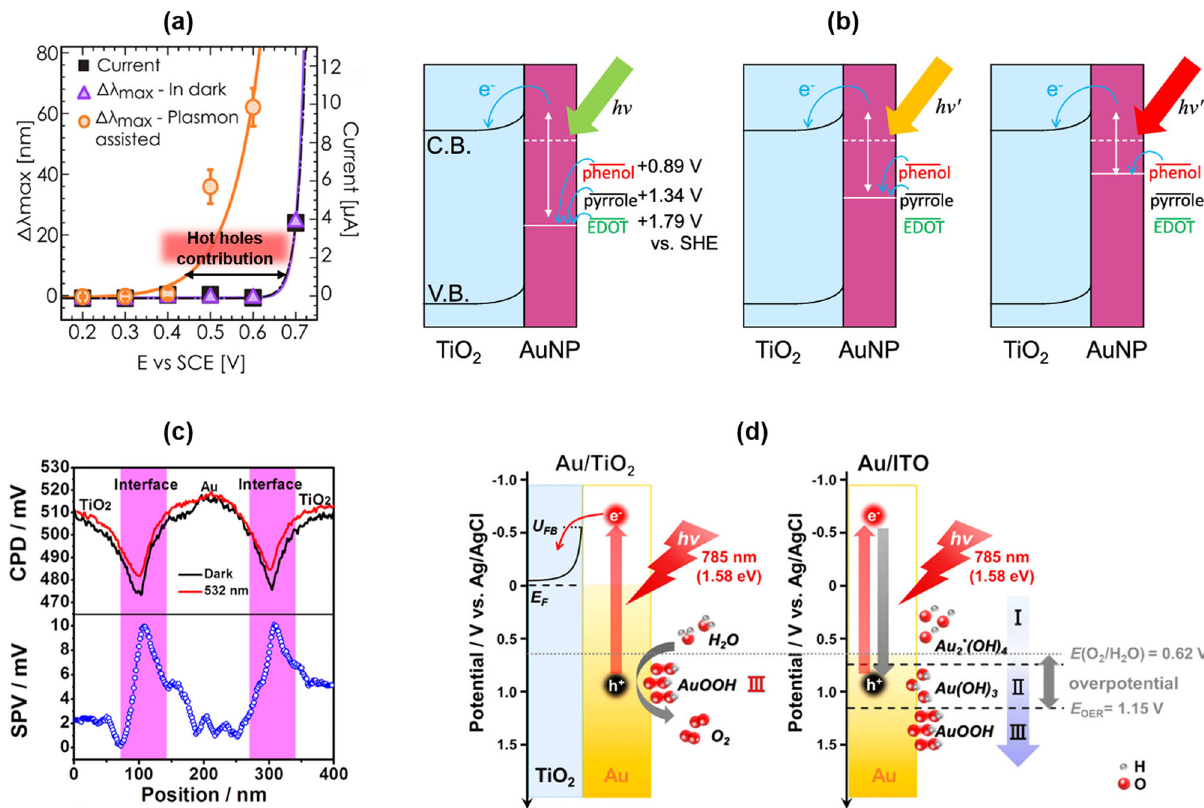
Fig. 8 Hot holes-driven polymerization and water oxidation reaction. a Change in the maximum scattering wavelength ( Δ λ max ) as a function of working electrode potential: the obtained threshold for polymerization reaction is 0.68 V in the dark and 0.44 V upon plasmon excitation (reprinted with permission from ref. 12 Copyright © 2019, American Chemical Society). b For the Au/TiO 2 interface, the excitation with different wavelengths results in hot holes with variable oxidation power that can polymerize monomers/adsorbates depending on their energetics relative to the hole (reprinted with permission from ref. 77 copyright © 2020, American Chemical Society). c Contact potential difference (CPD) for the dark state (black line) and state exposed with 532 nm light (red line). The surface photovoltage (SPV) pro fi le across the Au/TiO 2 particle indicates plasmonic holes creation near the gold – semiconductor interface (reprinted with permission from ref. 63 copyright © 2017, American Chemical Society). d Energy diagram of Au/TiO 2 and Au/ITO systems. The oxidation of water proceeds with a single intermediate in the Au/TiO 2 system with less overpotential than the Au/ITO system (reprinted with permission from ref. 87 copyright © 2020, American Chemical